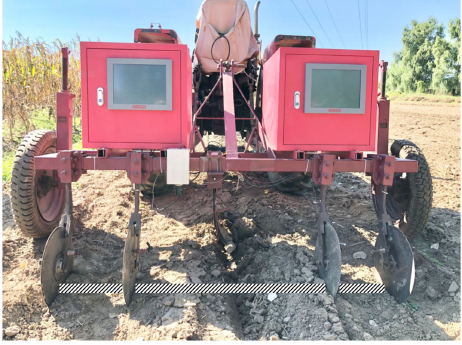
Figure 5. Physical image of